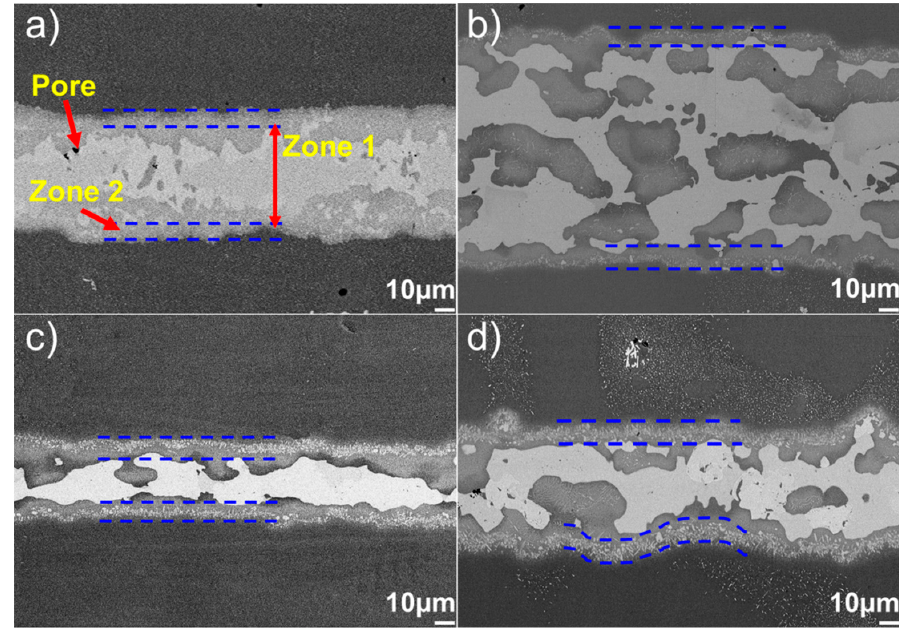
Figure 8. SEM back-scattered electron images of the DD98M/Pd-Si/DD98M joints brazed at 1060 ° C for different soaking time: ( a ) 10 min, ( b ) 30 min, ( c ) 60 min, and ( d ) 90 min.